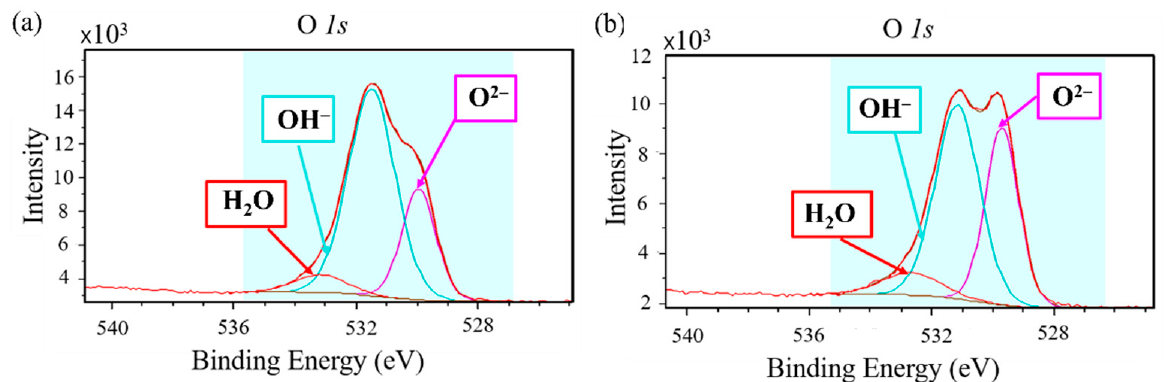
Figure 9. High-magnification narrow-scan O 1s profiles of Inconel 718 PA powder: ( a ) Virgin powder; ( b ) Ball-milled Figure 9. High ‐ magnification narrow ‐ scan O 1s profiles of Inconel 718 PA powder: ( a ) Virgin pow ‐ (30 min) der; ( b ) Ball ‐ milled (30 min) powder.